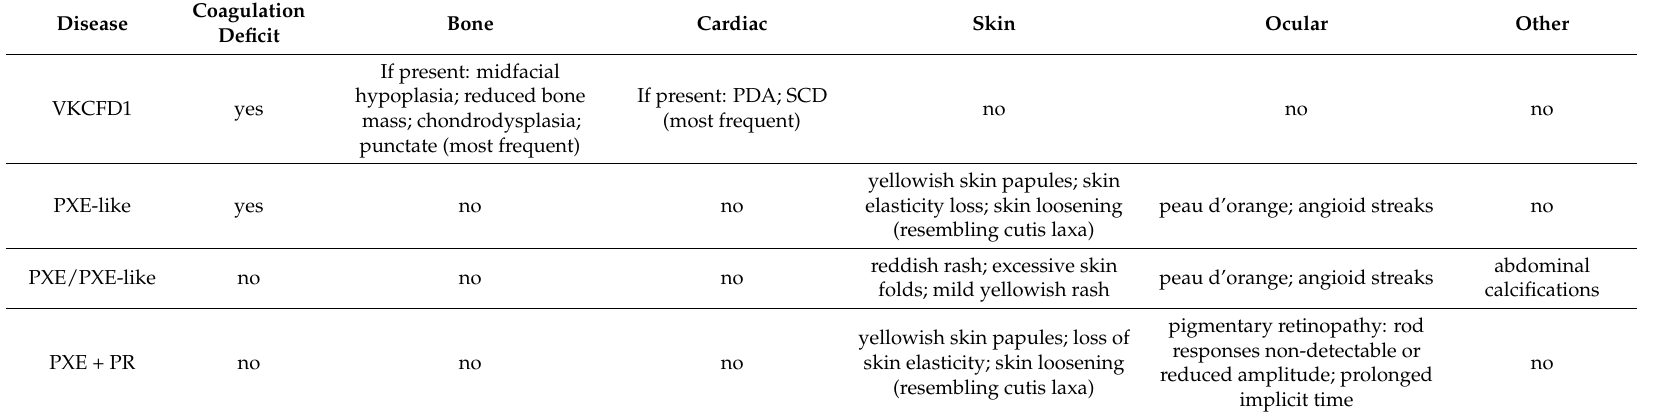
Table 1. Overview of the phenotypic features of the known gamma-glutamyl carboxylase (GGCX)-related disease